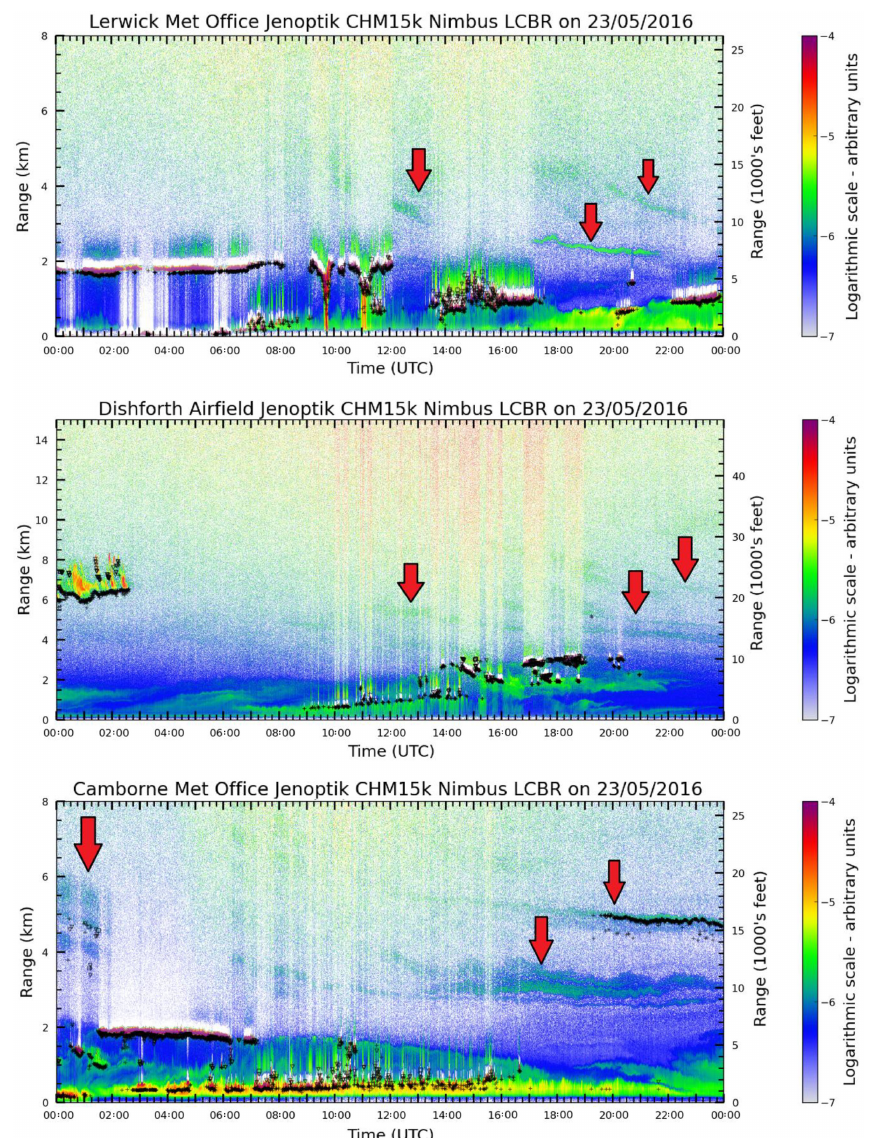
Figure 4. Variation of backscatter signal with time and height over the course of 23 May 2016 at three Met Office stations. The black marks indicate cloud bases. The dark-blue and green layers above 2km identified by the red arrows depict the aerosol